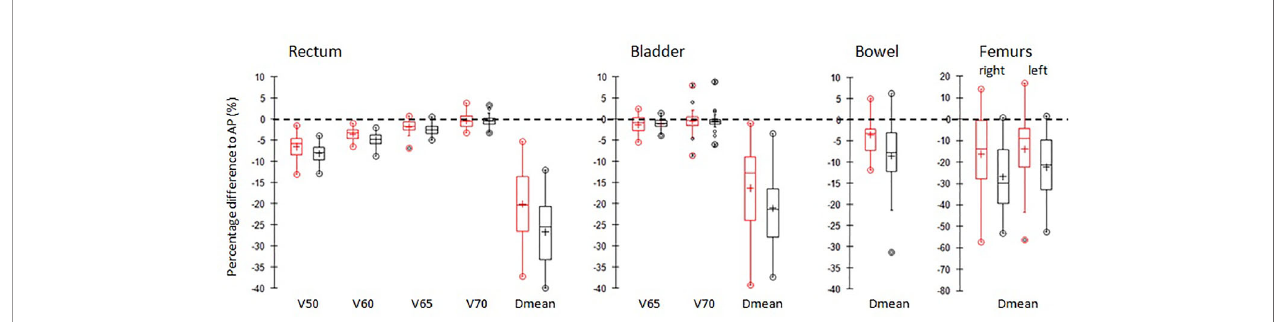
FIGURE 4 | Boxplots of differences of the main dosimetric metrics of AP plans (red) and Pers plans (black) compared to MP plans for rectum, bladder, femurs, and small bowel irradiation. PTVs. The central line marks the median, the edges of the box are the 25th and 75th percentiles, black circles represent the extreme values. The crosses represent the